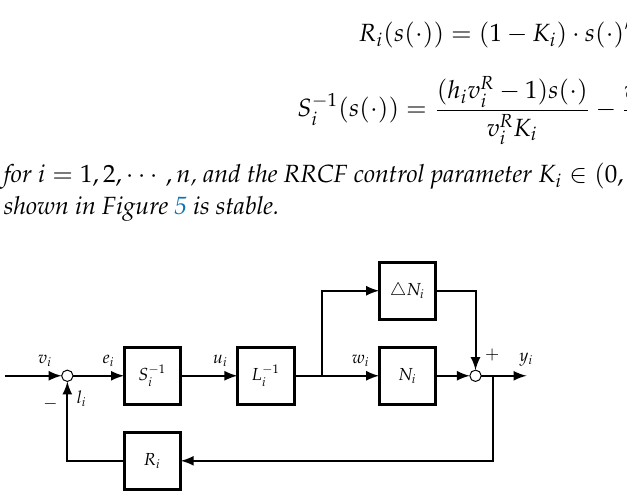
Figure 5. RRCF control of the decoupled MIMO